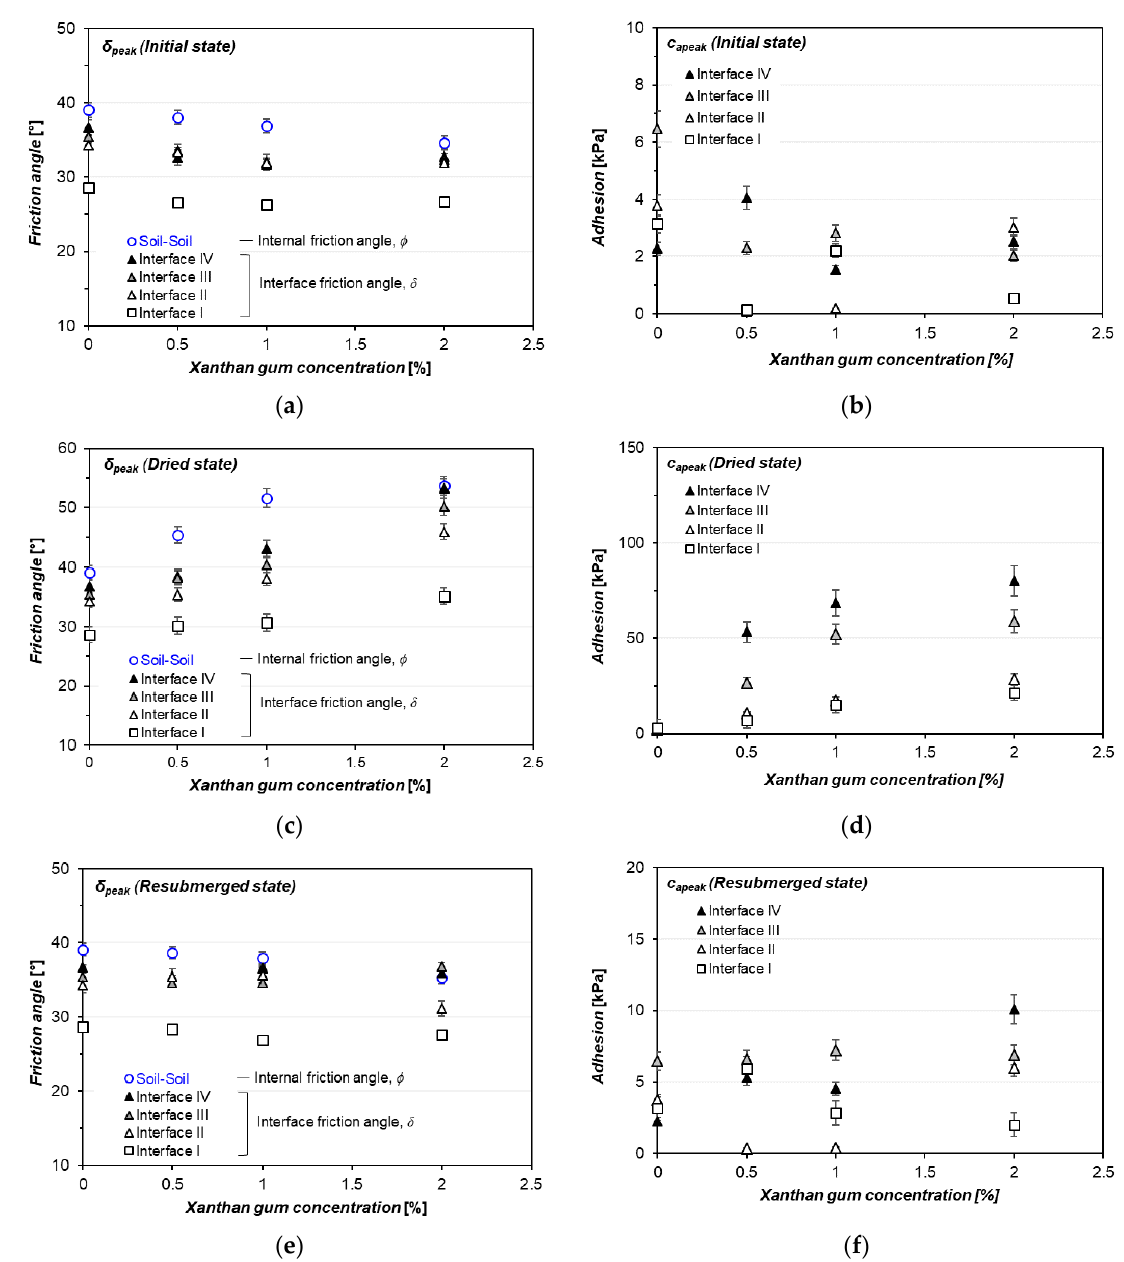
Figure 13. Peak interfacial shear parameters of xanthan gum-treated sand (soil–structure interface): ( a , b ) peak interface friction angle ( δ peak ) and adhesion ( c apeak ) in initial state, ( c , d ) peak interface friction angle ( δ peak ) and adhesion ( c apeak ) in dried state, and ( e , f ) peak interface friction angle ( δ peak ) and adhesion ( c apeak ) in resubmerged state.